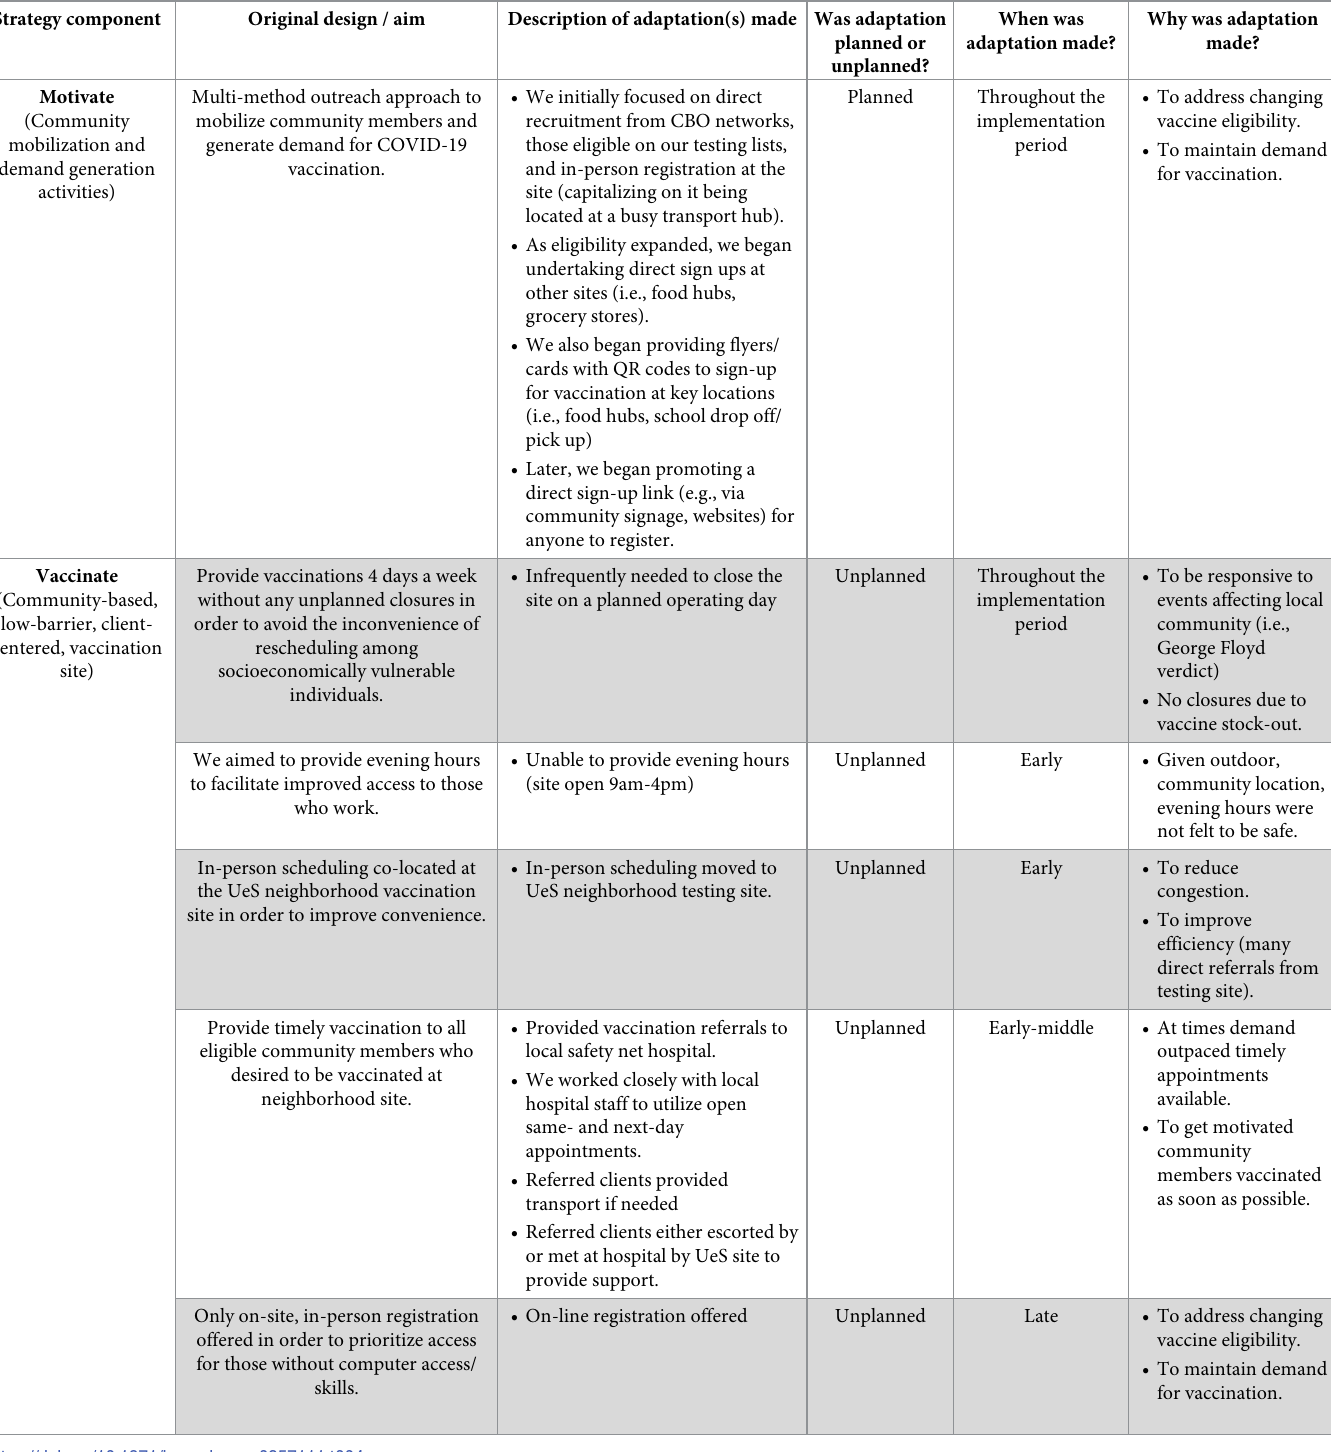
Table 4. Adaptations to the “Motivate, Vaccinate and Activate” strategy components during the implementation period from February 1 through May 19,